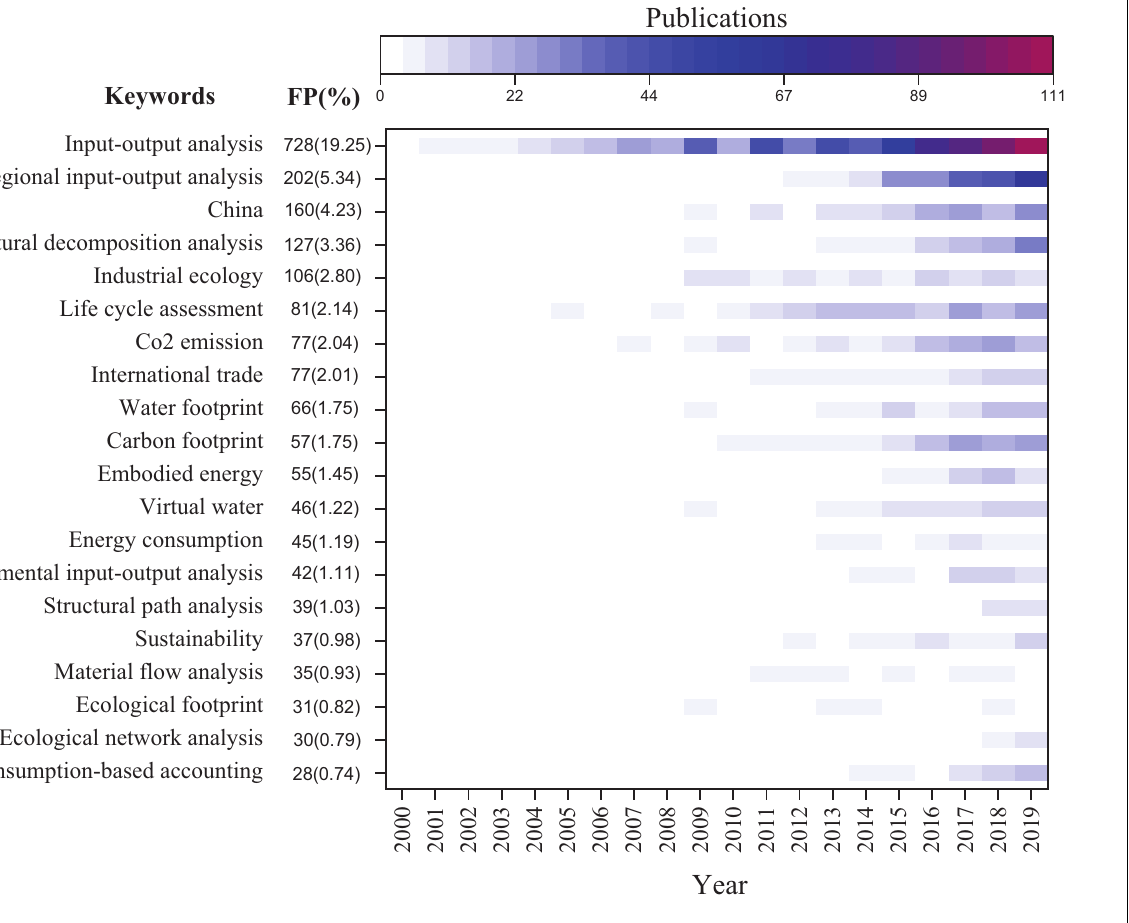
FIGURE 5 | Frequency distribution of research topics. The color bar represents publications per year of keywords.